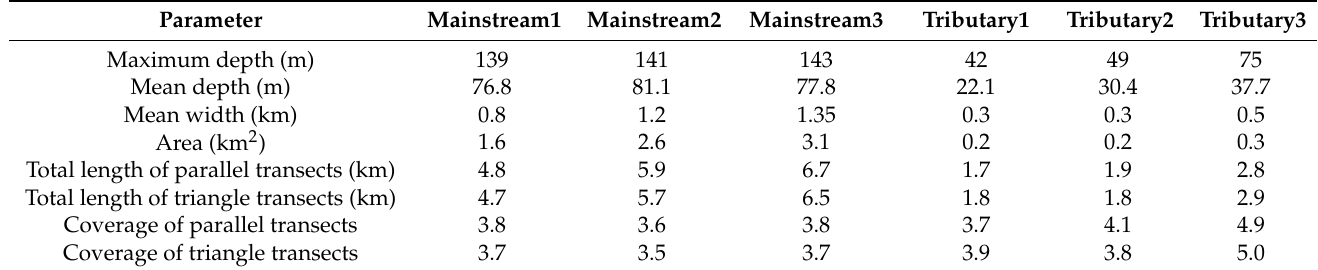
Table 1. Morphometric and transect information of the survey units in the mainstream and the